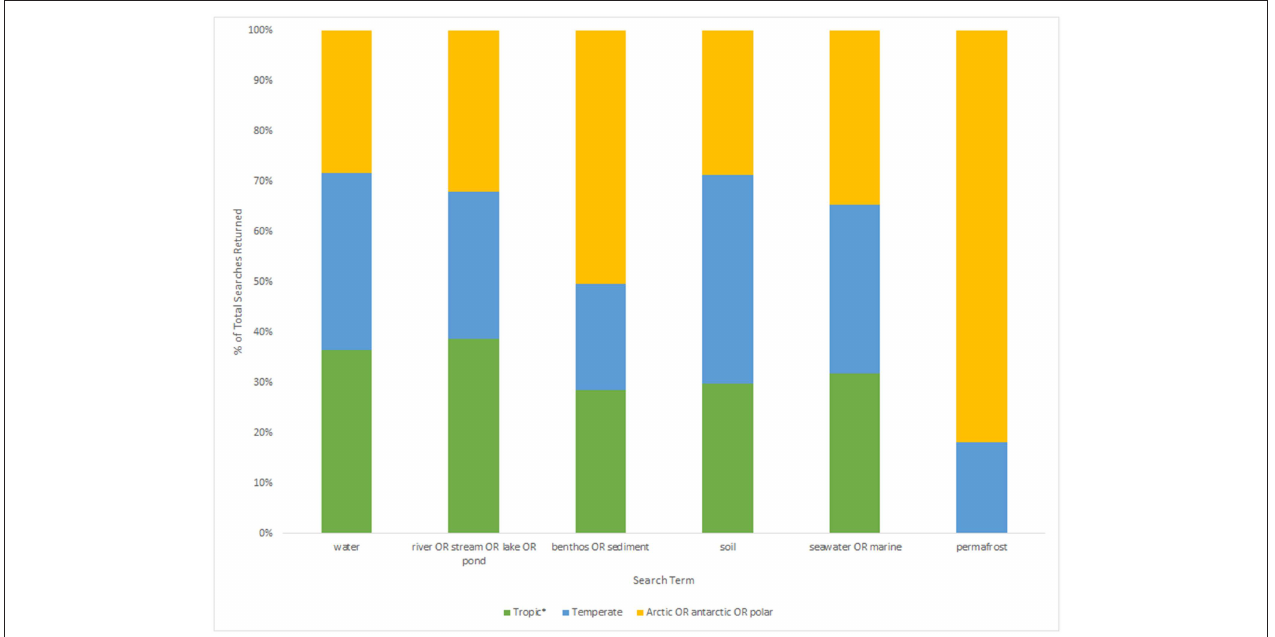
FIGURE 1 | Histogram displaying the percentage of total results returned (tropic*: n = 242, temperate: n = 157, arctic/Antarctic/polar: n = 292; based on Table 2 ) for each sample type search term (water, river/stream/lake/pond, benthos/sediment, soil, seawater/marine, and permafrost) for each geographic region.